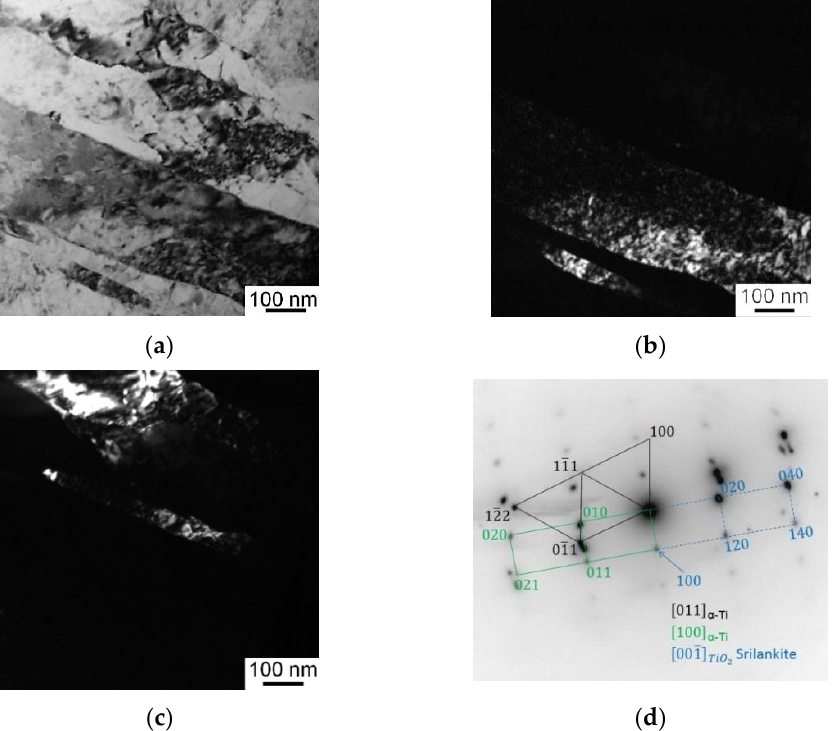
Figure 6. TEM bright- ( a ) and dark-field ( b , c ) images and an associated SAED pattern ( d ) illustrating the microstructure the of Ti-6Al-4V samples subjected to UIT. The TEM micrographs were obtained at a depth of 45 µm below the treated surface. The dark-field micrographs were obtained with the 011 α-Ti ( b ) and 01(cid:3364)1 α-Ti ( c ) reflections. The fragmentation of the retained β-Ti interlayers causing the misorientation be- tween adjacent β-Ti subgrains is also observed at a depth of 45 µm below the treated